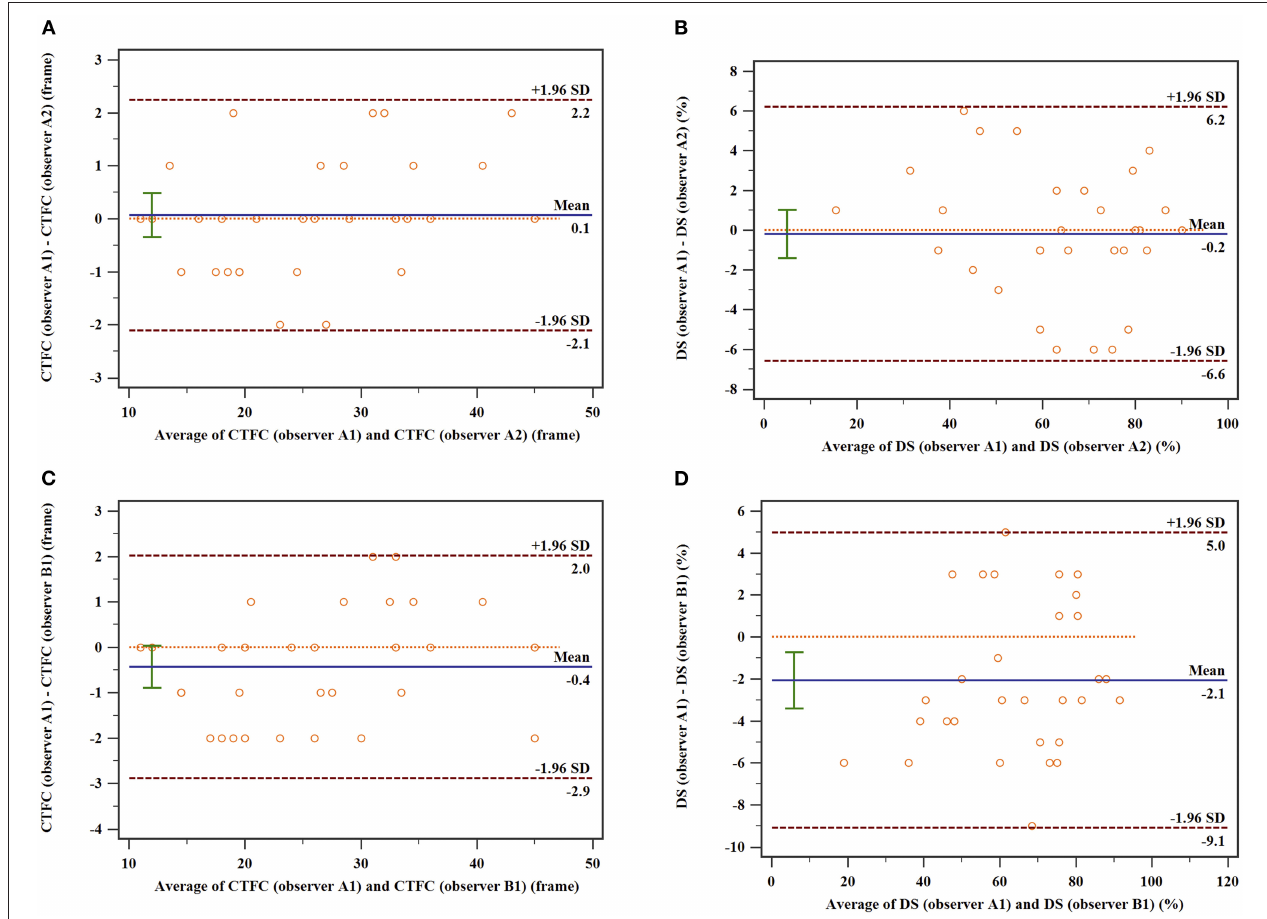
FIGURE 5 | Bland–Altman plots of the intra-observer and inter-observer variability of CTFC. (A) Intraobserver variability in CTFC; (B) Intraobserver variability in DS; (C) interobserver variability in CTFC. (D) Interobserver variability in DS.The upper and lower dotted lines indicate the mean difference ± 1.96 SD, and the middle dotted line is used as the zero line, while the solid line depicts the mean difference between the two measurements.